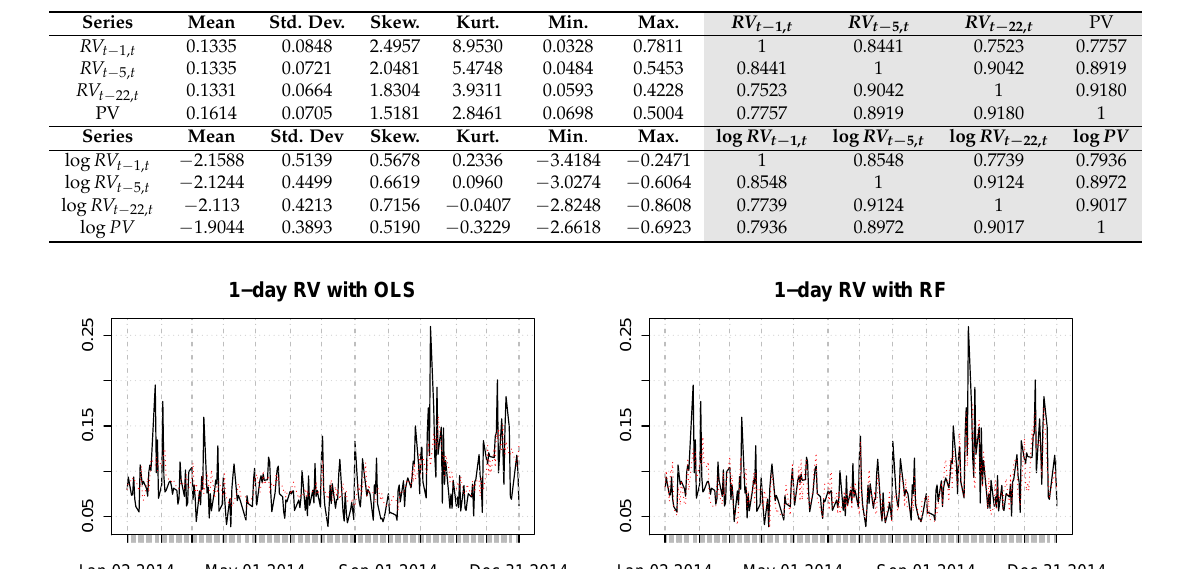
Table 1. Statistical summary of S&P/ASX 200’s 15-second realised volatility at different time horizons